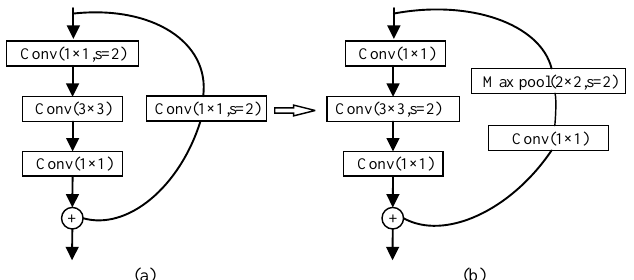
Figure 9. ( a ) Residual block structure of the standard ResNet50; ( b ) Improved residual block structure.